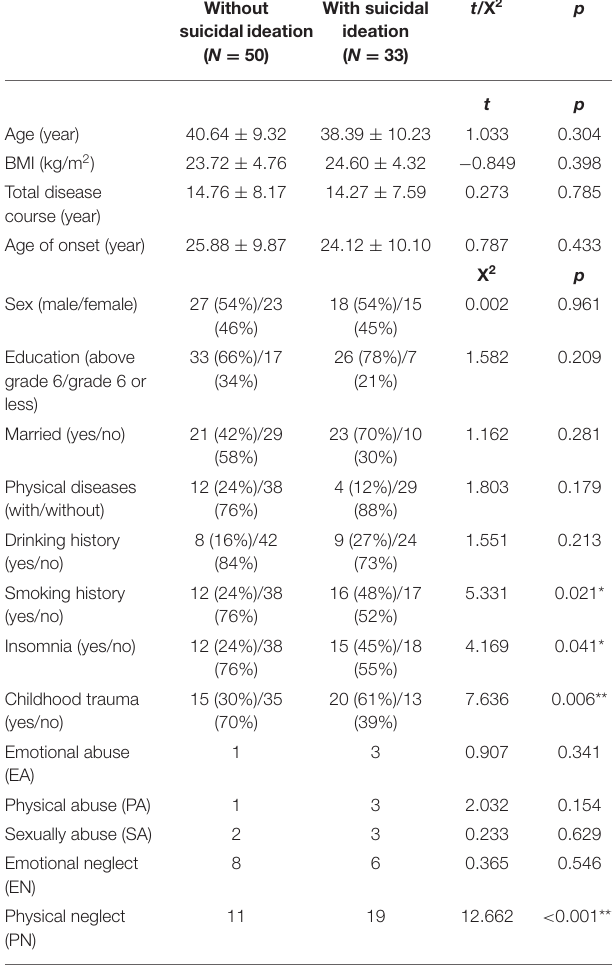
TABLE 1 | Demographic characteristics of schizophrenic patients with or without suicidal ideation.